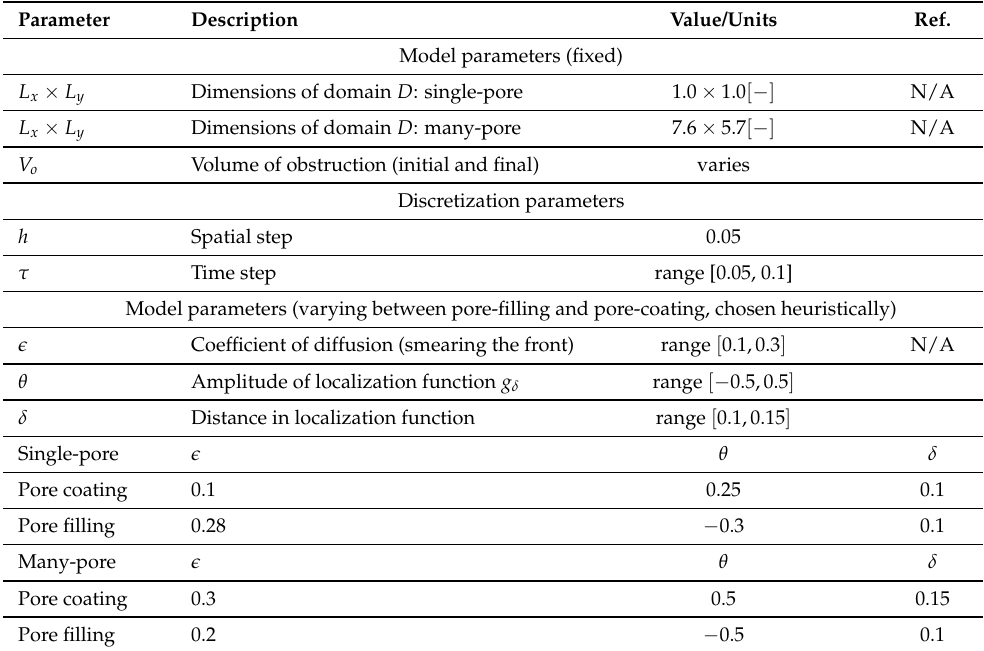
Table 3. Parameters for CLPS model from Section 4.3 in single-pore and many-pore geometry. The model uses nondimensional rather than physical units.